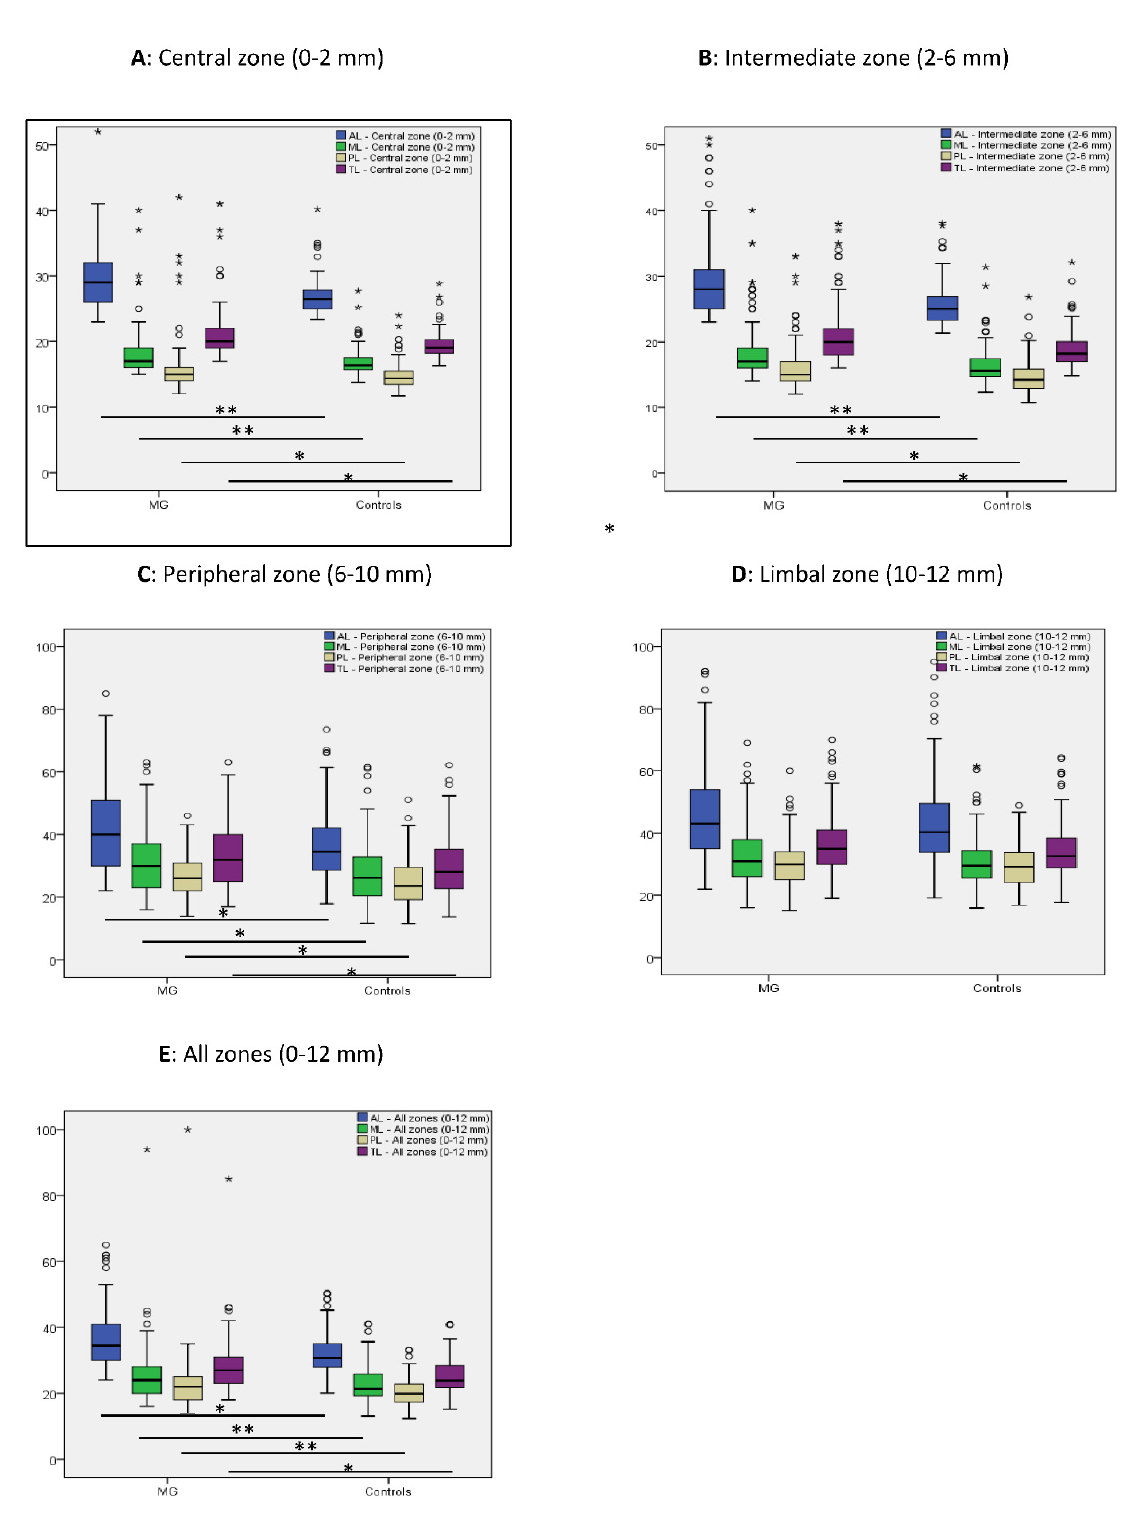
Figure 2. Corneal densitometry values at the central ( A ), intermediate ( B ), peripheral ( C ) and limbal ( D ) annular corneal zones and in all stromal zones (0–12 mm) ( E ) using Pentacam (Oculus, Wetzlar, Germany) at the anterior (AL), middle (ML) and posterior (PL) corneal stromal layers and along the complete corneal thickness (TL) in monoclonal gammopathy (MG) and in control subjects. Small circles in the graphs show extreme values and stars outliers. p values show results of the statistical analysis using Mann–Whitney U test. p values below 0.001 are marked with “**”, other significant p values are marked with